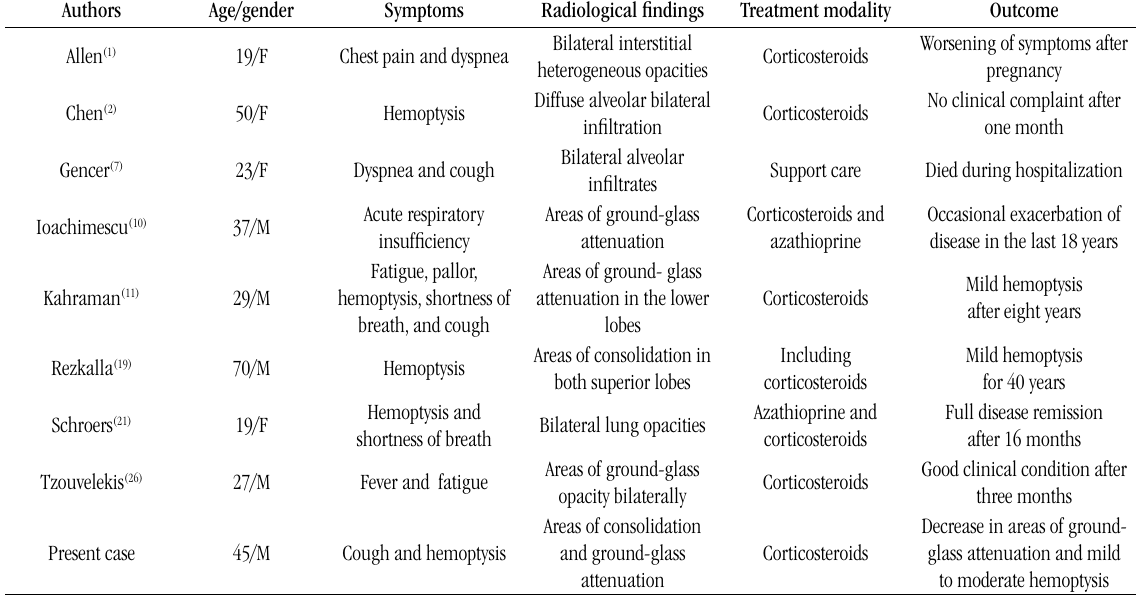
tABLE 2 – Summary of some published cases of